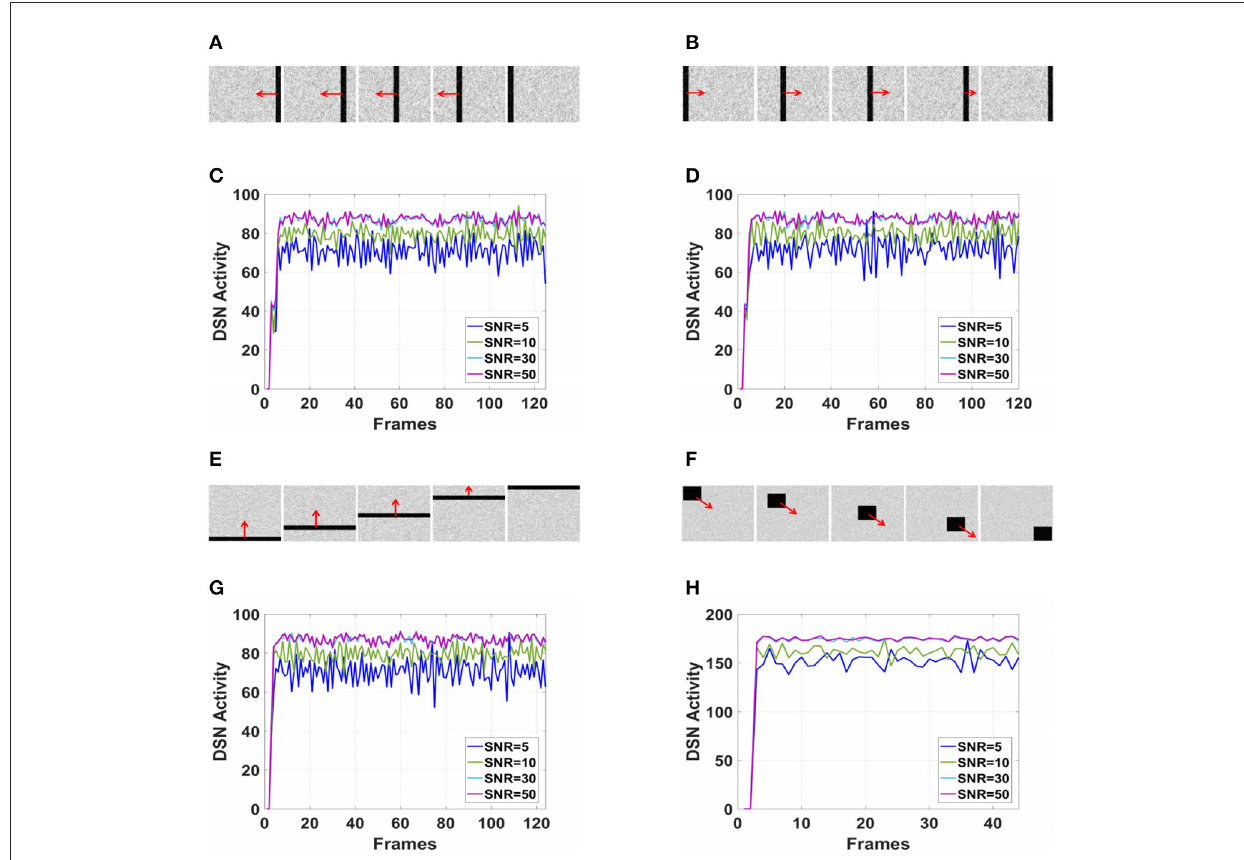
FIGURE8 The output of proposed visual neural networks in real motion directions under different signal-to-noise ratios. (A) Object translating leftwards. (B) Object translating rightwards. (C) θ = π . (D) θ = 0. (E) Object translating upwards. (F) Object right lower corner motion. (G) θ = π /2. (H) θ =7 π /4.